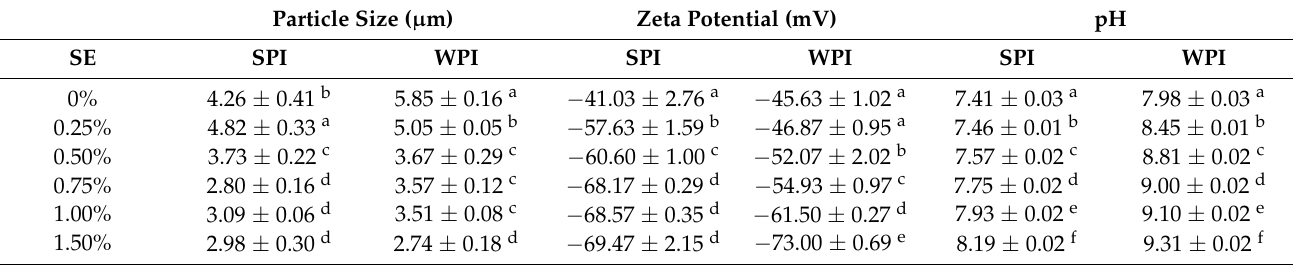
Table 1. Particle size and Zeta potential of emulsion at different concentrations of